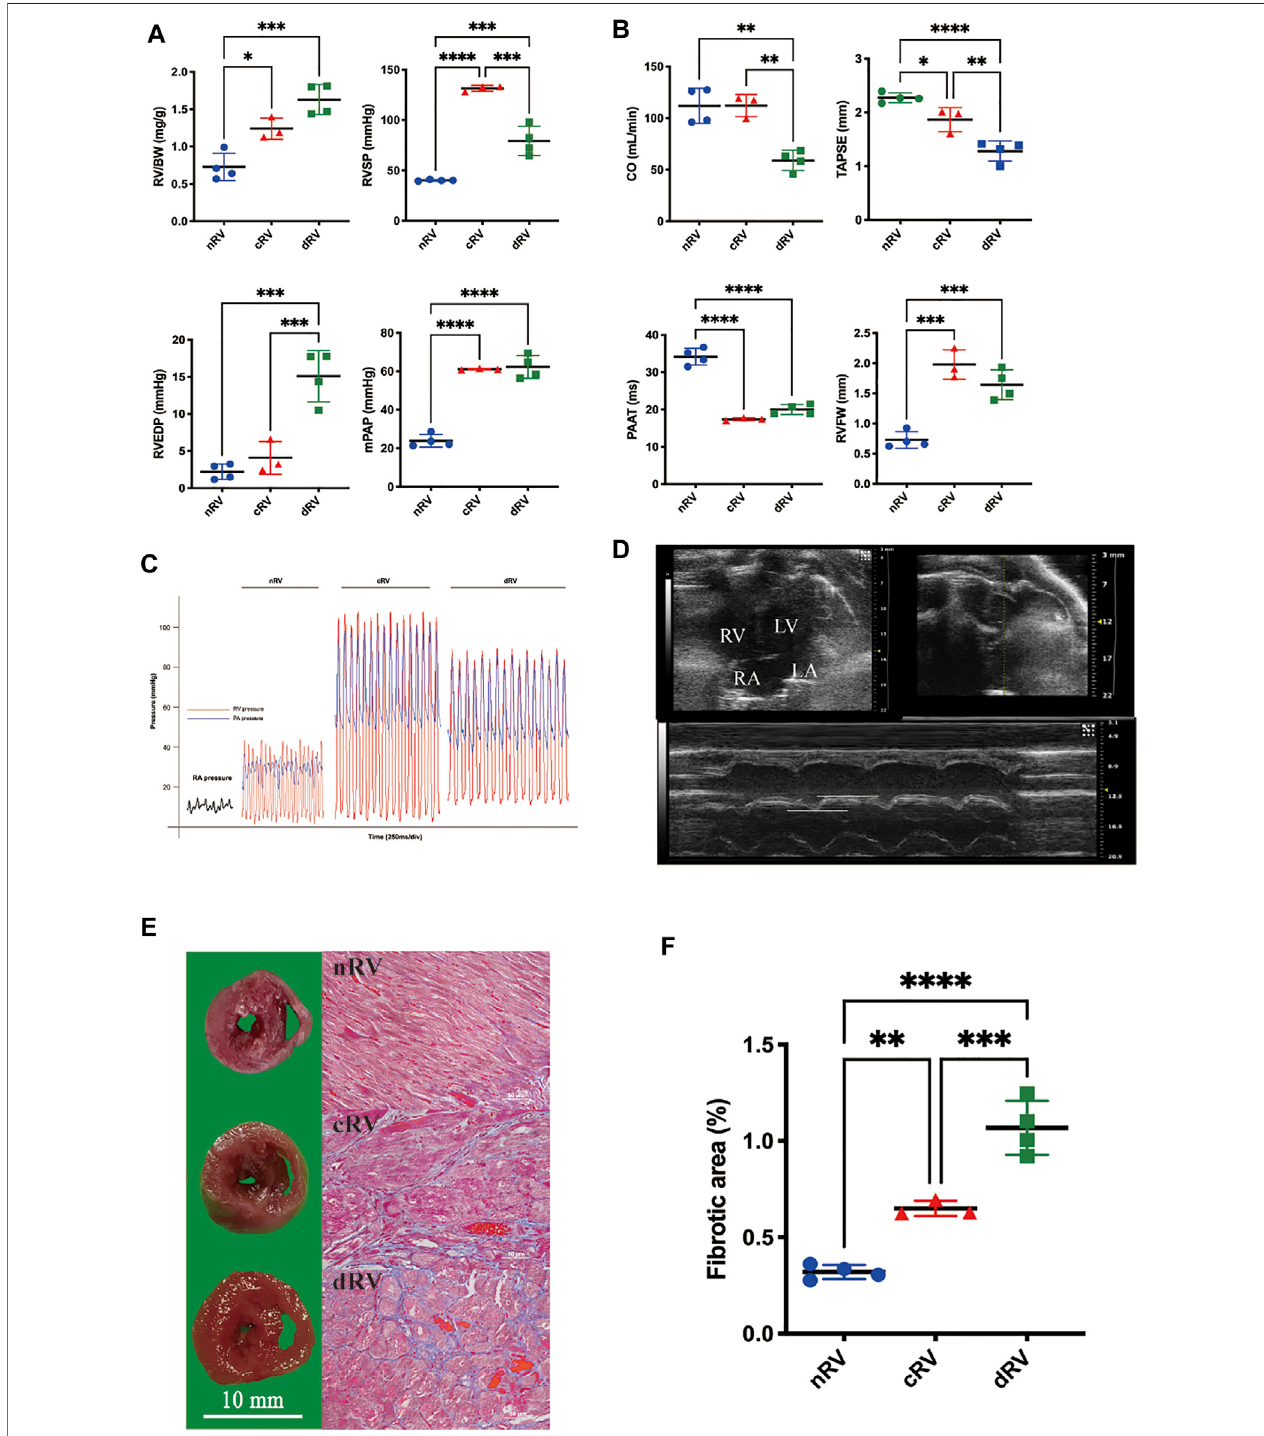
FIGURE 2 | Development of the rat model of monocrotaline-induced right ventricular failure. (A) RV weight and hemodynamic indexes evaluated by right heart catheterization of saline- and MCT-induced rats at cRV and dRV stages. (B) Right ventricular function indexes evaluated by echocardiographic of saline- and MCT- induced rats at cRV and dRV stages. (C) Pressure waves of the rat model from right heart catheterization. (D) An echocardiographic image of the four-chamber view of theratheartandtheexplanationofhowTAPSEwasmeasured. (E) Cross-sectionalviewoftherightventricleandthe fi broticareaestimatedbyMasson ’ strichrome stain at nRV, cRV, and dRV stages. (F) The column chart of the fi brotic area at different stages. nRV, normal right ventricle; cRV, compensated right ventricle; dRV, decompensated right ventricle; RV/BW, ratio of right ventricle to body weight; RVSP, right ventricular systolic pressure; RVEDP, right ventricular end-diastolic pressure; mPAP,meanpulmonary arterialpressure;CO,cardiacoutput;TAPSE,tricuspid annularplanesystolicexcursion;PAAT,pulmonaryarteryaccelerationtime;and RVFW, right ventricular free wall thickness.